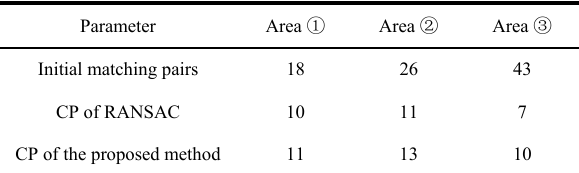
Table 2 Algorithmic performance statistics in matching stage.